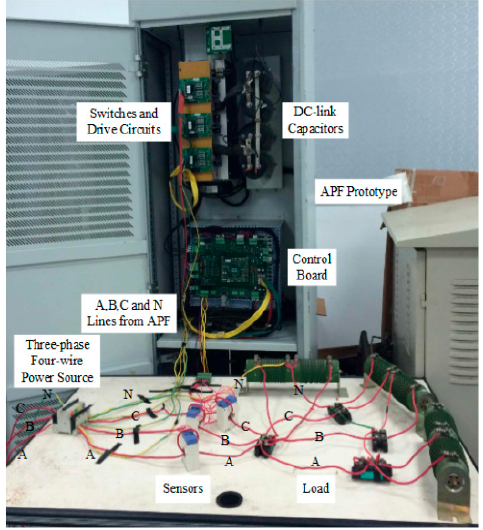
Figure 4. The APF prototype.